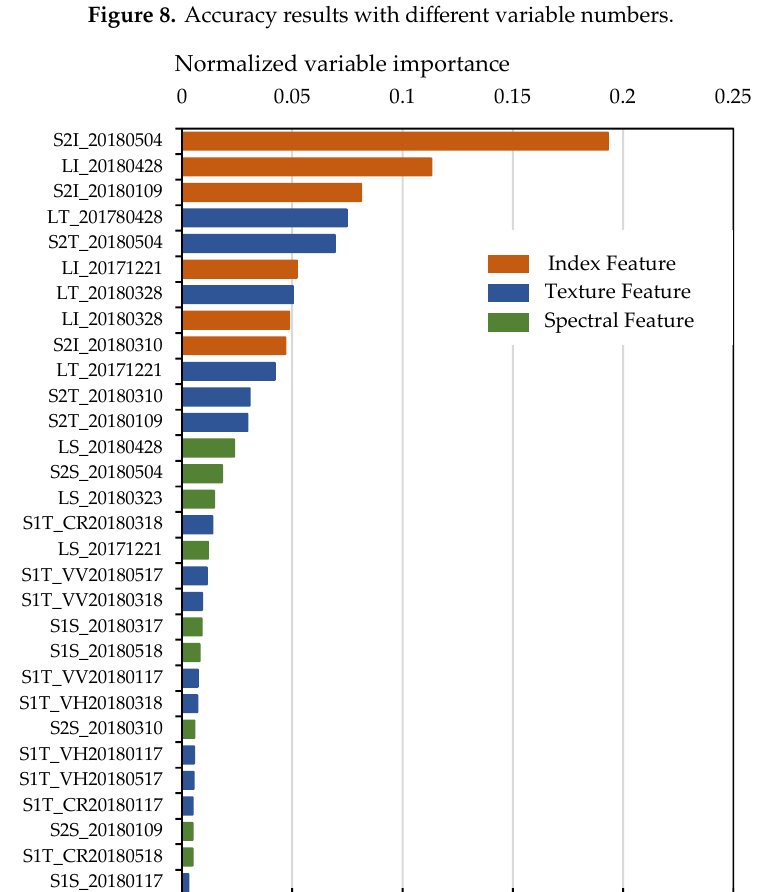
Figure 9. Importance of variables in the RF classification process.